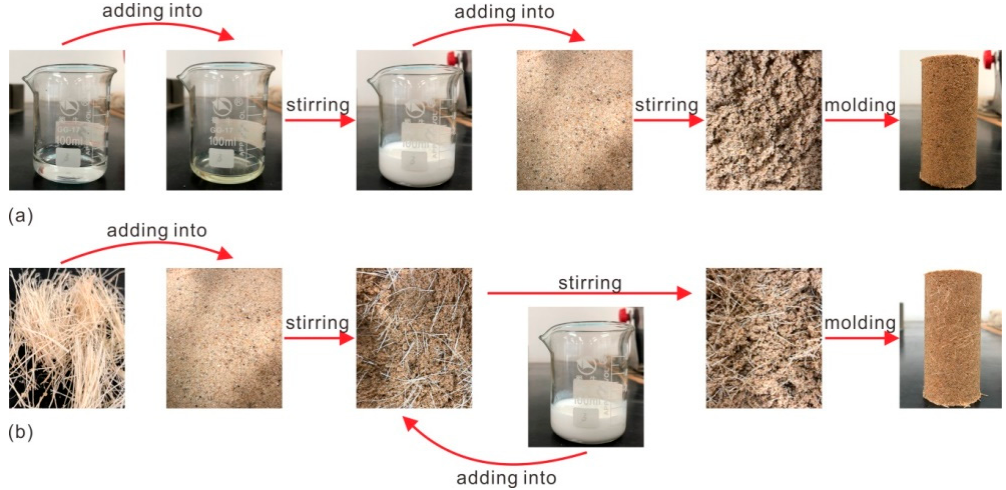
Figure 4. The diagram of the composite specimen fabrication: ( a ) OPSS and ( b ) OPSS with fiber.